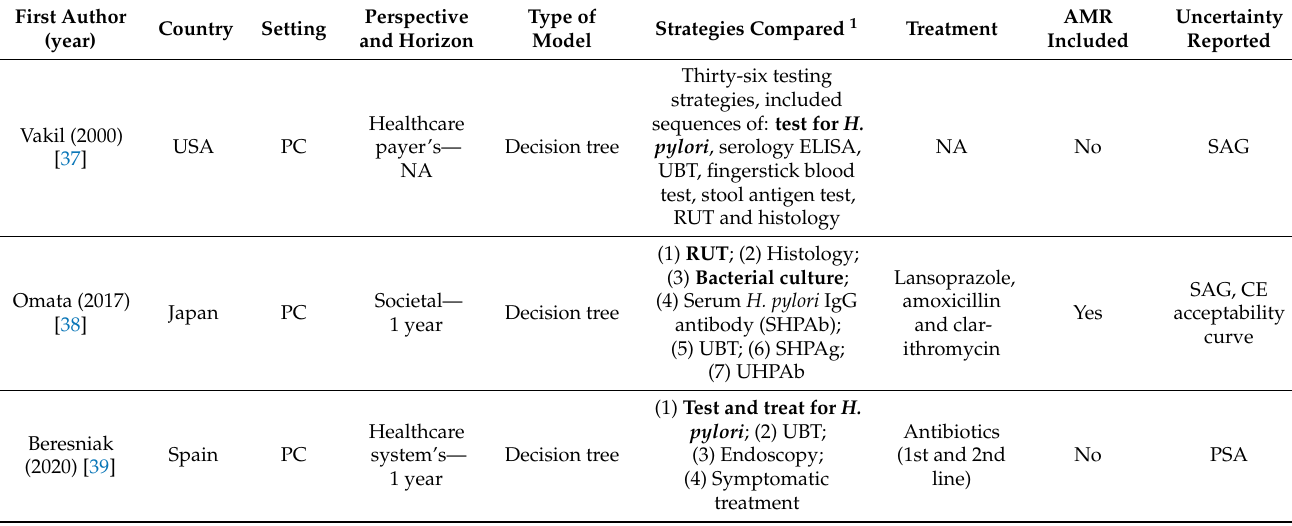
Table 4. Articles related to diagnosing H. pylori infection with other